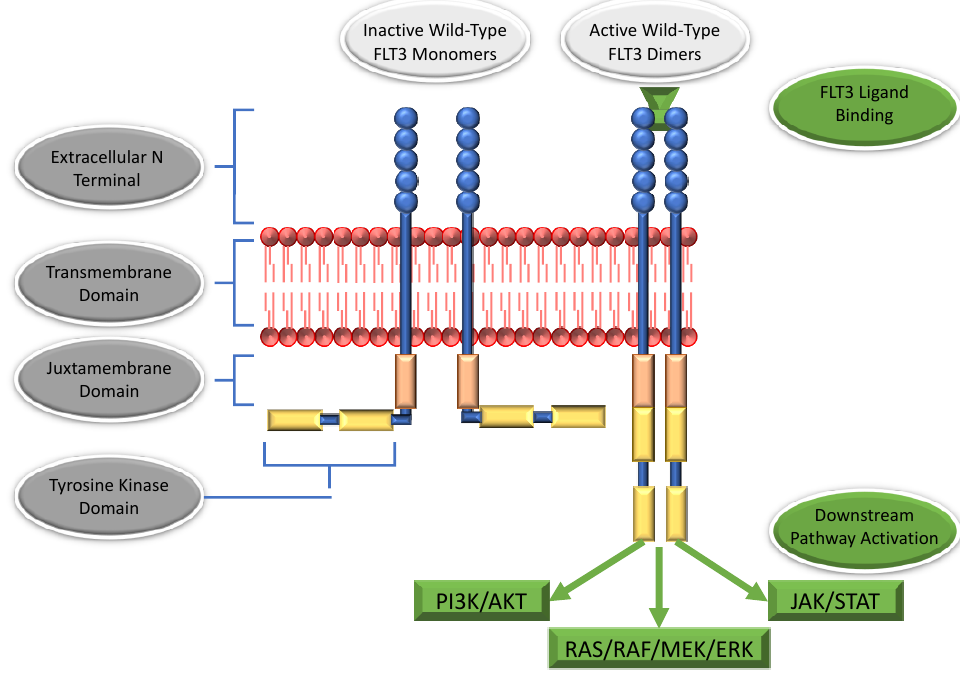
Figure 1. Wild-type FLT3 is held in an inactive, monomeric conformation. Upon FLT3 ligand binding, FLT3 dimerizes, auto-phosphorylates, and undergoes a conformational change, leading to activation of downstream signaling pathways associated with cellular growth, proliferation, and survival.